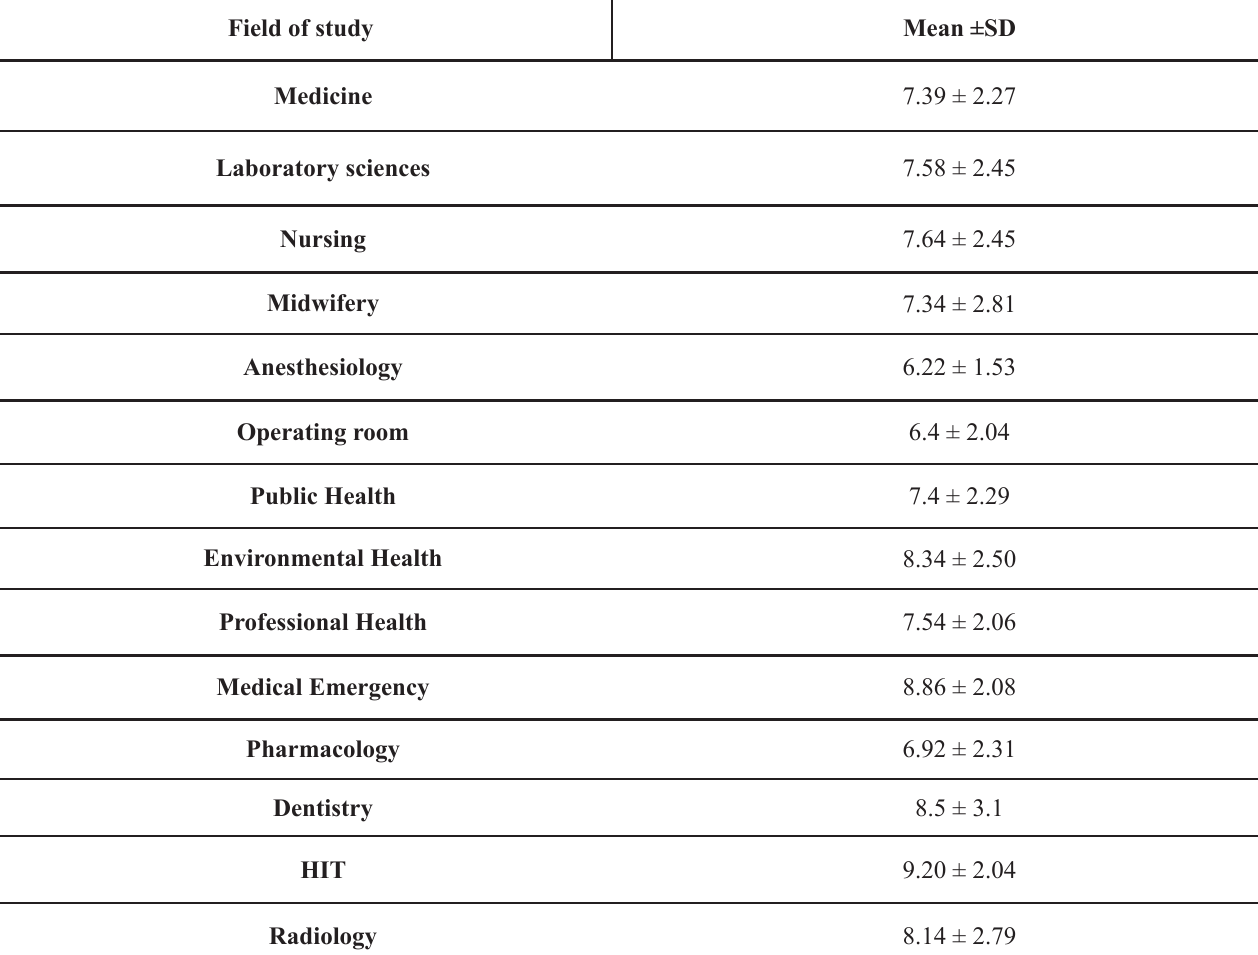
Table 3: Sleep quality score of students participating in study by the field of